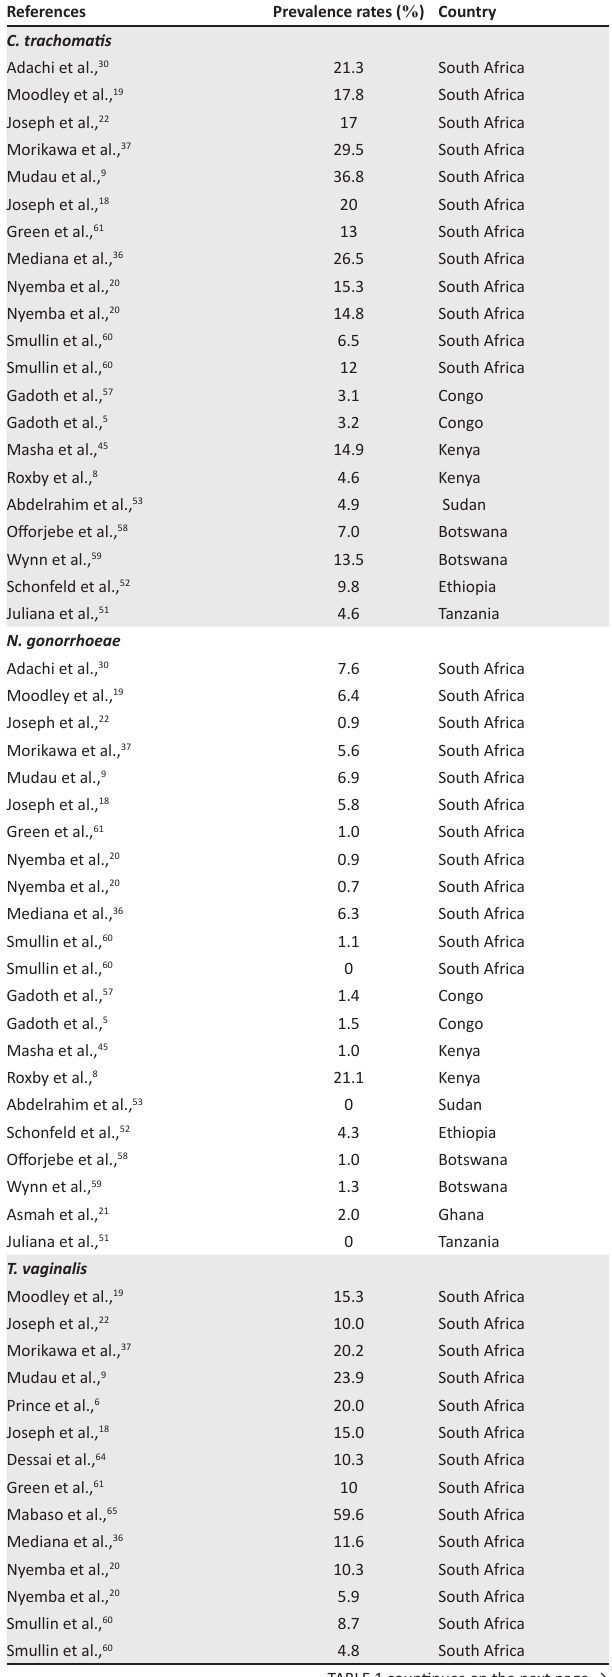
TABLE 1: Summary of prevalence data for sexually transmitted infections in pregnant women from sub-Saharan